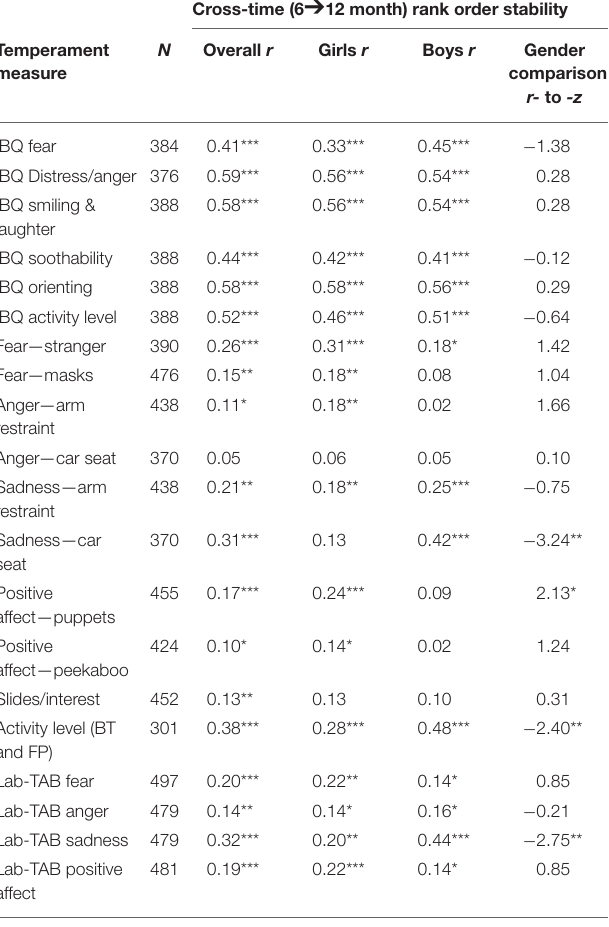
TABLE 6 | Cross-time (rank order) stability for infant temperament measures. : Cross-time (6 12 month) rank order